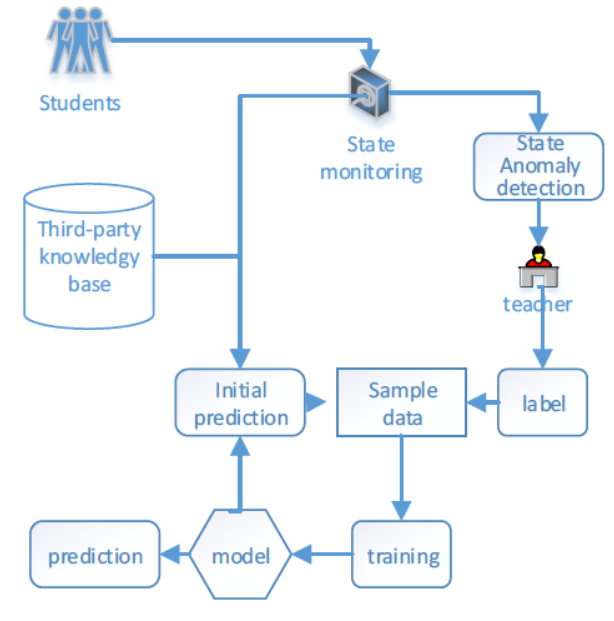
Fig. 2. Prediction method of students’ cognitive